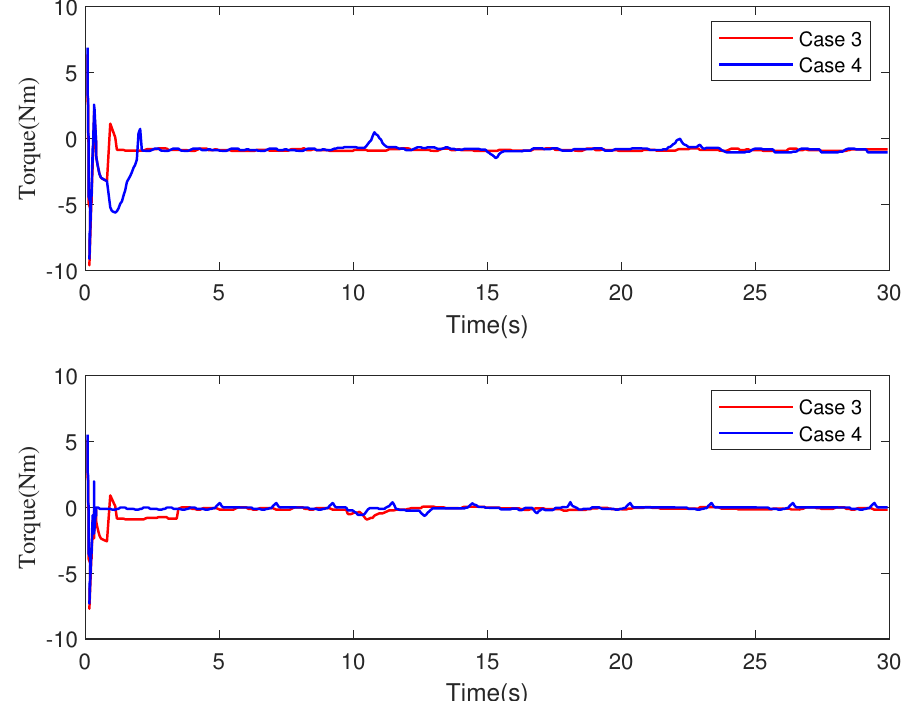
Figure 11. Torque of the 2-DOF robot manipulator in Case 3 and Case 4.